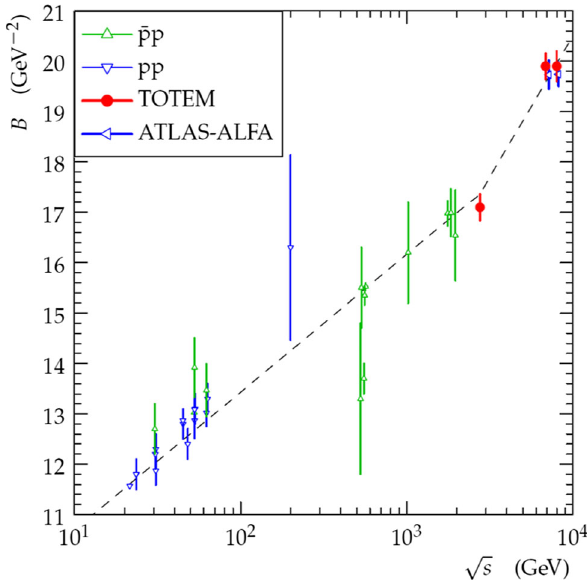
Fig. 1 The experimental data about the diffraction cone slope B ( s ) [30]